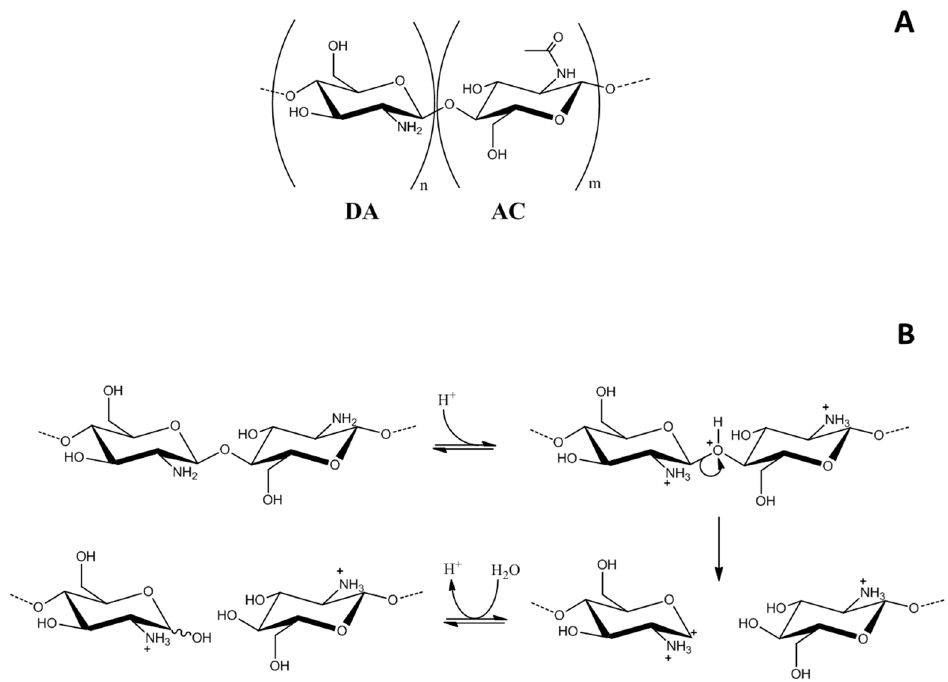
Figure 1. ( A ) Schematic representation of the structure repeat units of chitosan; ( B ) schematic representation of the chitosan degradation mechanisms.